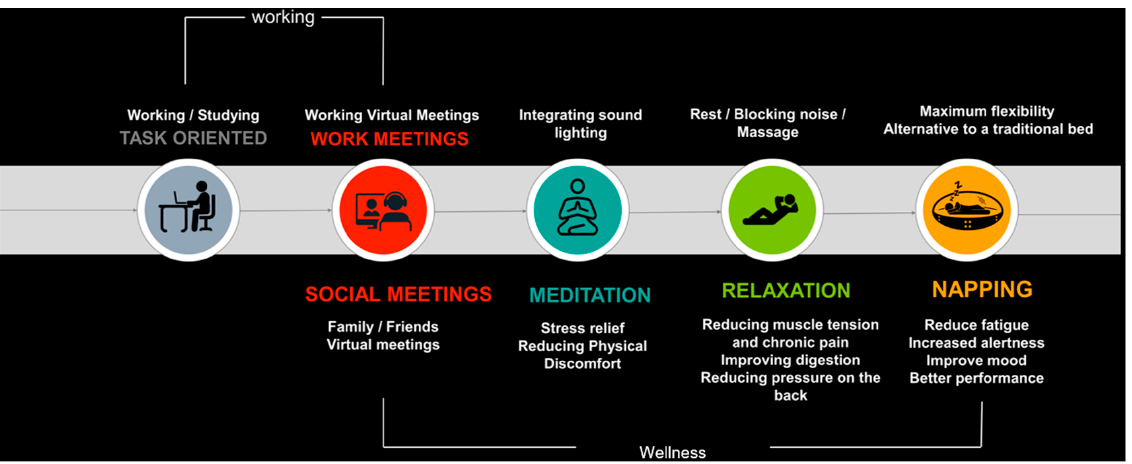
Figure 3. The “Reviving Pod” is presented in plan side elevation, and 3D perspective views, illus- trating the pod’s interior design, including the recliner seat, parametric wall unit, smart projection screen, LED light, and adjustable working surface (design by the authors).